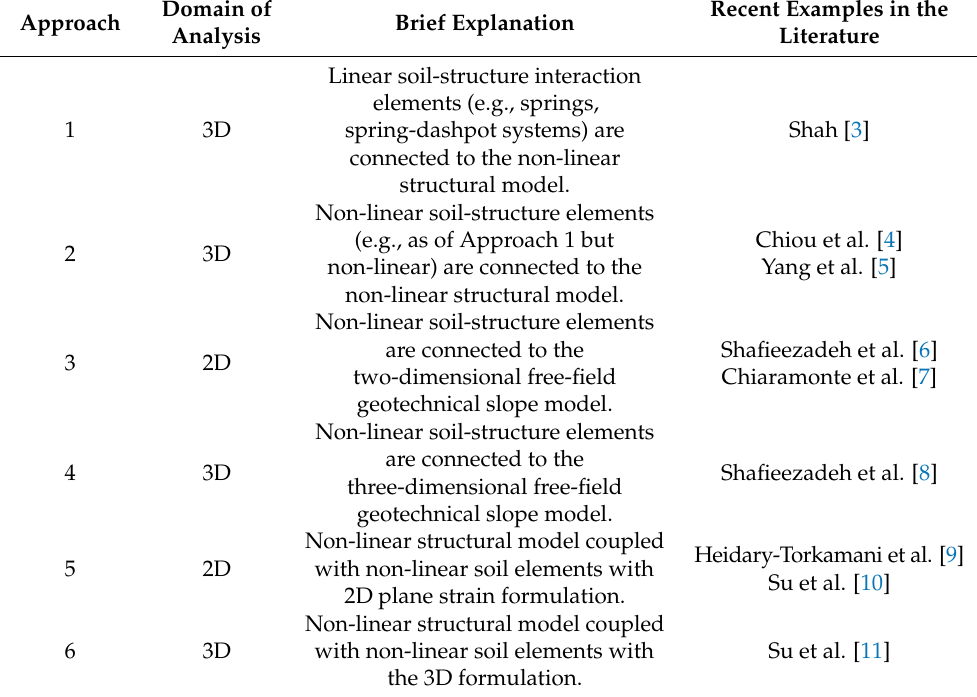
Table 1. Recent examples of mainstream analysis